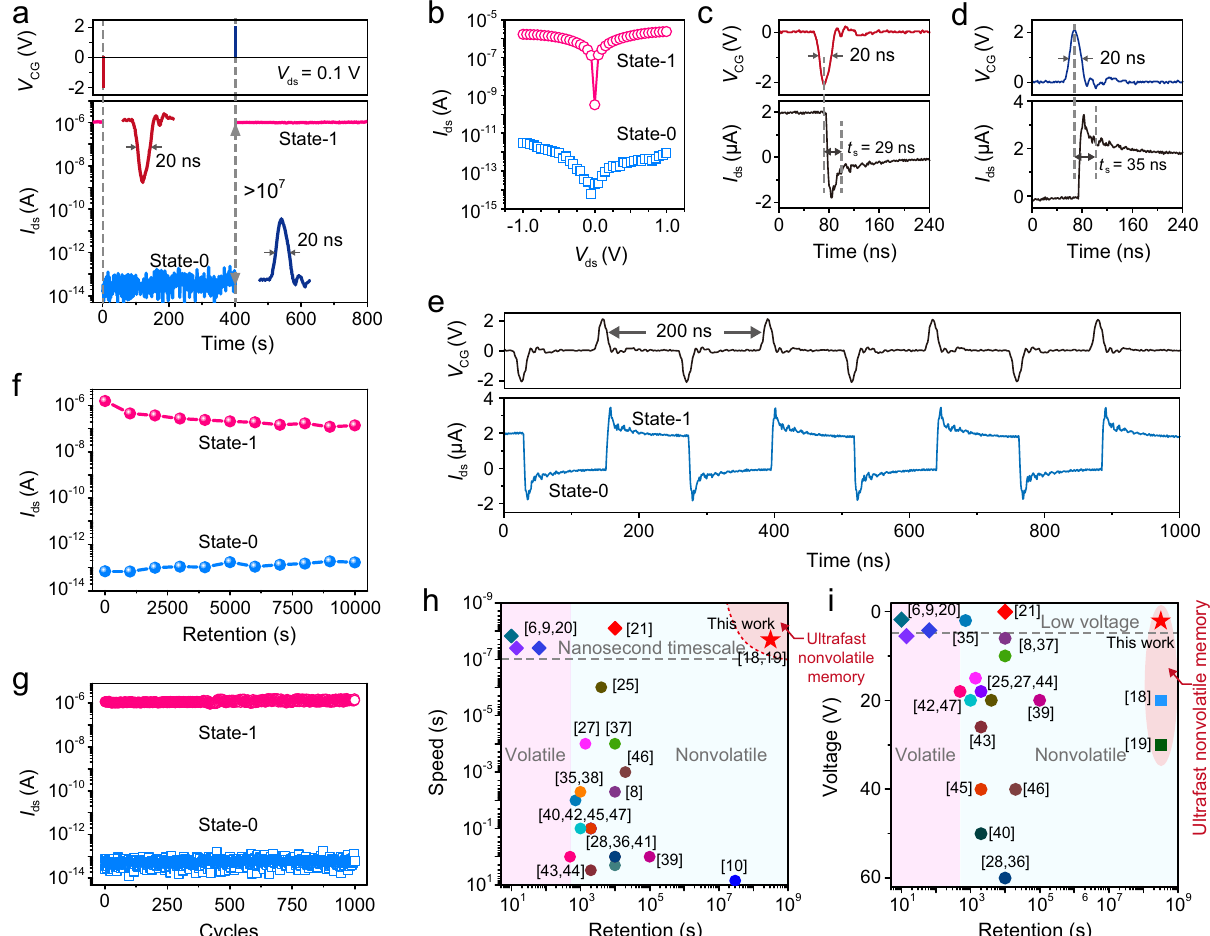
Fig. 3 | Performance of the low-voltage ultrafast nonvolatile memory. a Ultrafast writing and erasing operations of the device. The readout operation at V V ds =0.1V and CG =0V demonstrated a large state-1/state-0 ratio of over 10 7 . The insets present the actual writing/erasing V CG pulses with FWHM of 20ns and amplitude of – 2V and 2V, respectively. b Output curves of the memory at state-1 (pink)andstate-0(blue),respectively.Transientcurrentresponsesofthedeviceby applying – 2V/20ns ( c ) and + 2V/20ns ( d ) V CG pulses for ultrafast writing and erasing operations. e Demonstration of ultrahigh-frequency operation by